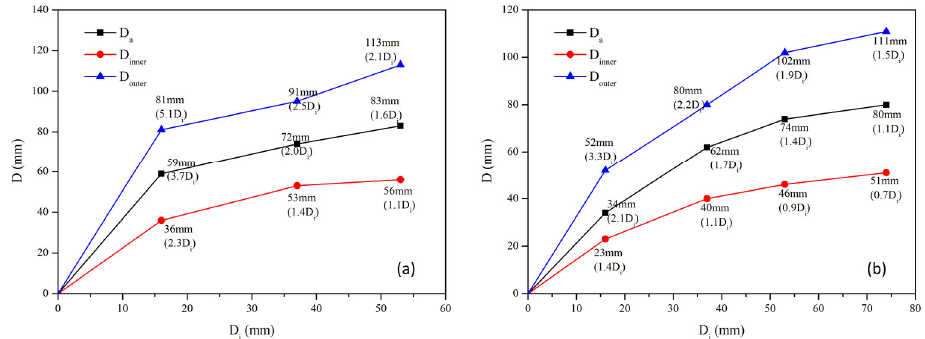
Figure 6. The diameters of the impinging circles formed under different ideal tangential circles for ( a ) gas-phase corner- injected flow and ( b ) gas–particle two-phase corner-injected